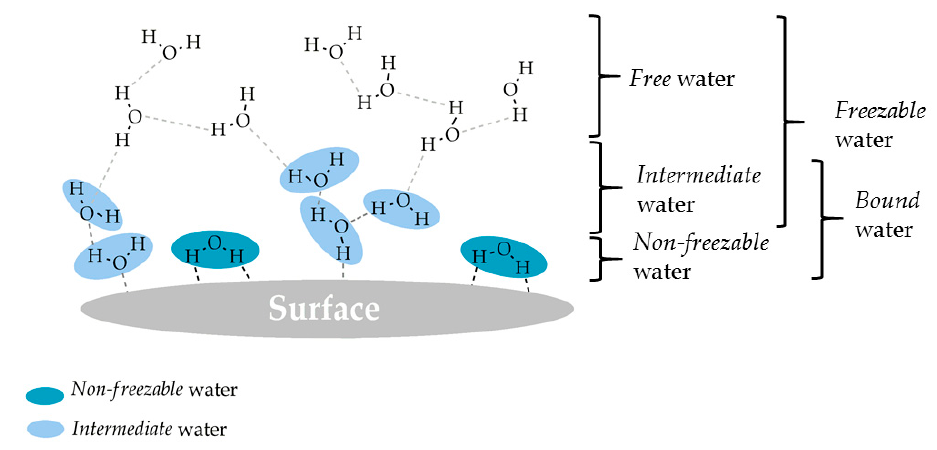
Figure 2. Types of water on surfaces with the denominations, their structure and interactions on surfaces.